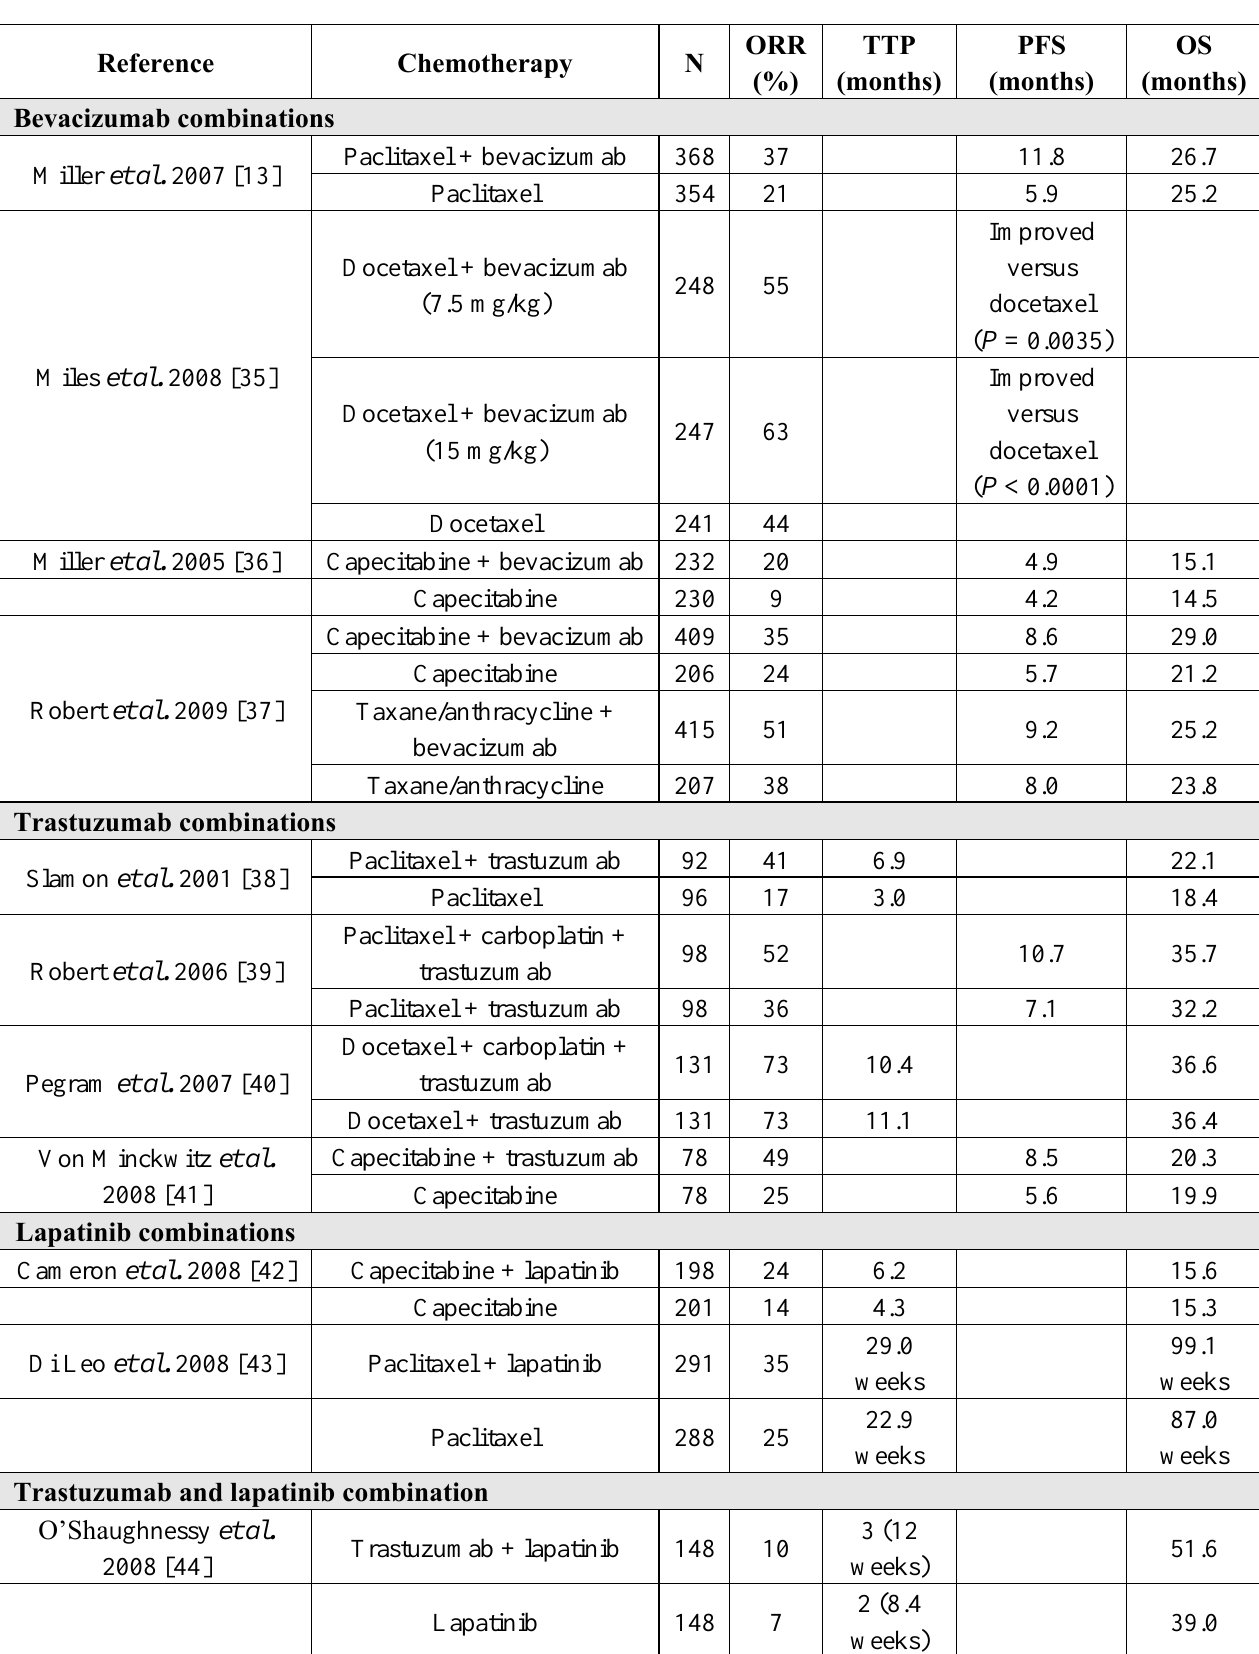
Table 2. Summary of phase III clinical trials combining chemotherapy and targeted biologic therapy for the first-line treatment of